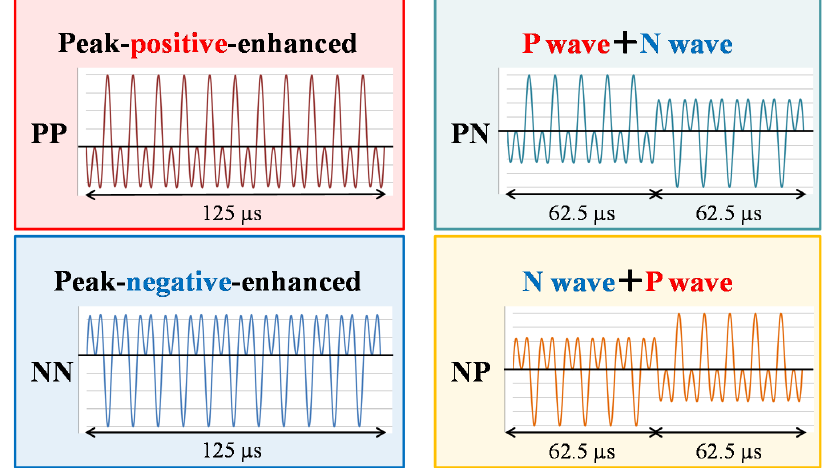
Figure 3. Schematics of four kinds of dual-frequency ultrasound sequences. 1.6-MHz ultrasound was superimposed onto a 0.8-MHz ultrasound to emphasize either peak positive pressure (P wave) or peak negative pressure (N wave) by adjusting the phase difference between two frequency